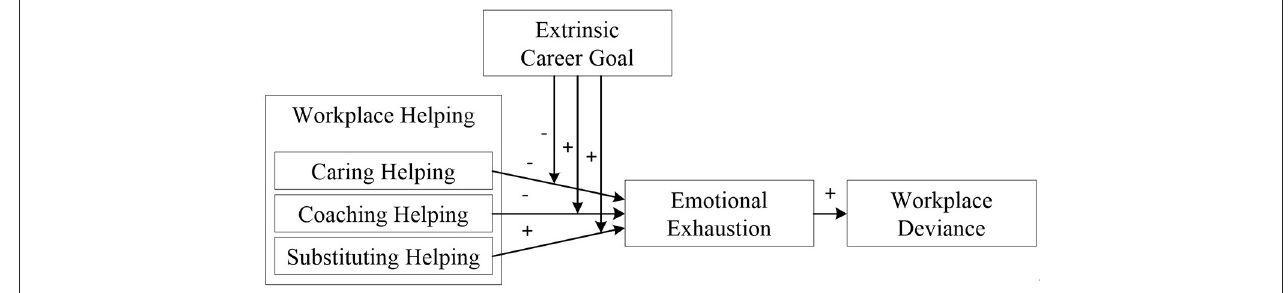
FIGURE 1 | The conceptual mode of this